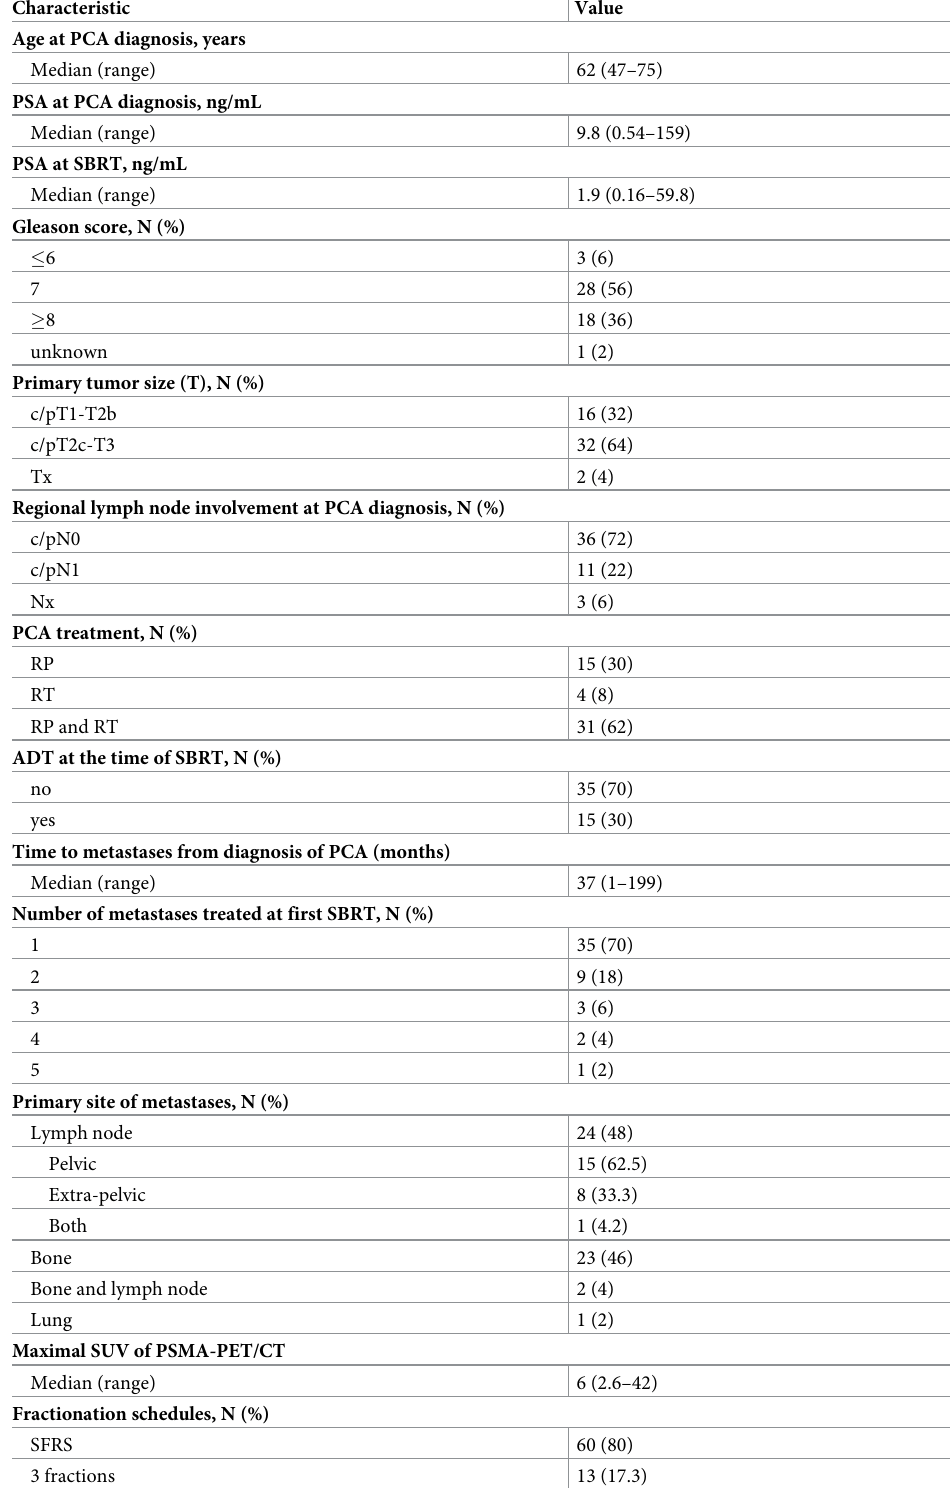
Table 1. Patients, tumor and treatment